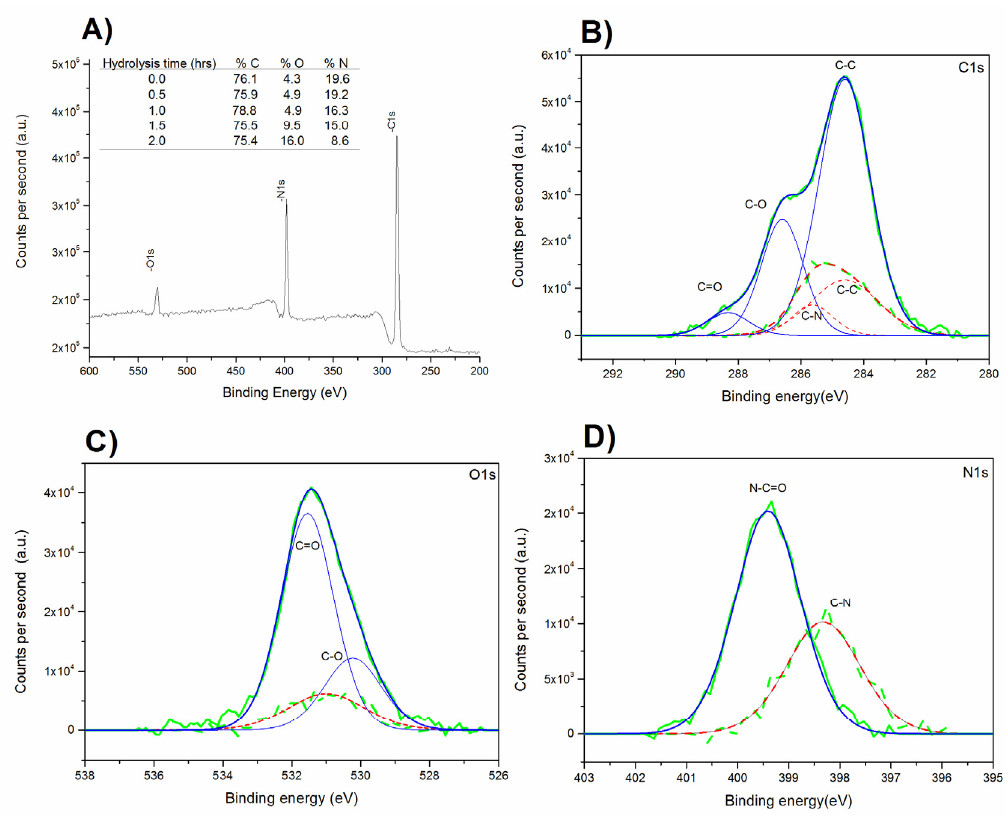
Figure 2. ( A ) XPS (X-ray photoelectron spectroscopy) curves of PAN membranes and atomic surface composition of PAN membranes at different hydrolysis times. Deconvolution of untreated (--, red ) and hydrolyzed (—, blue ) (1.5 h) PAN membranes for ( B ) C1s, ( C ) O1s, and ( D ) N1s peak.